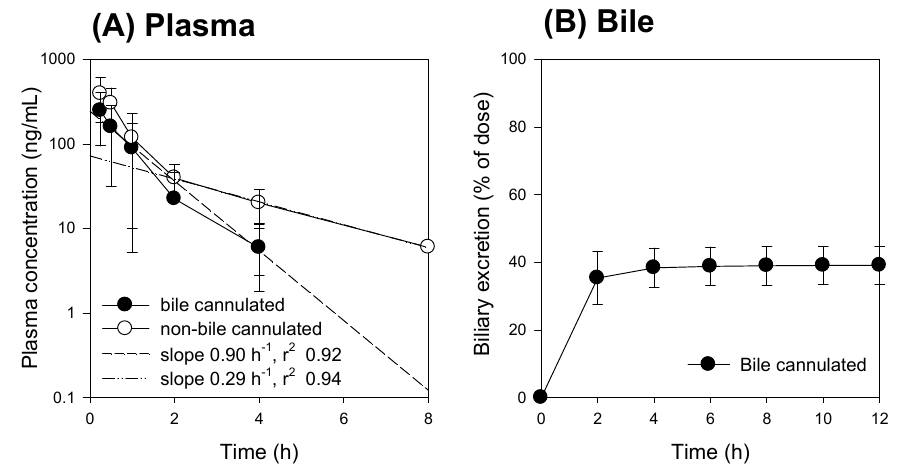
Figure 8. ( A ) Plasma concentration and ( B ) biliary excretion of compound K following intravenous injection at a single dose of 2 mg/kg in the bile-cannulated rats ( ● ) and in the non-bile-cannulated rats ( ○ ). Dotted lines represent the regression line of the elimination constant from the plasma concentrations of compound K. Data expressed as mean ± standard deviation from four rats per group. Table 5. Pharmacokinetic parameters of compound K in rats of bile cannulation and non-bile cannulation.